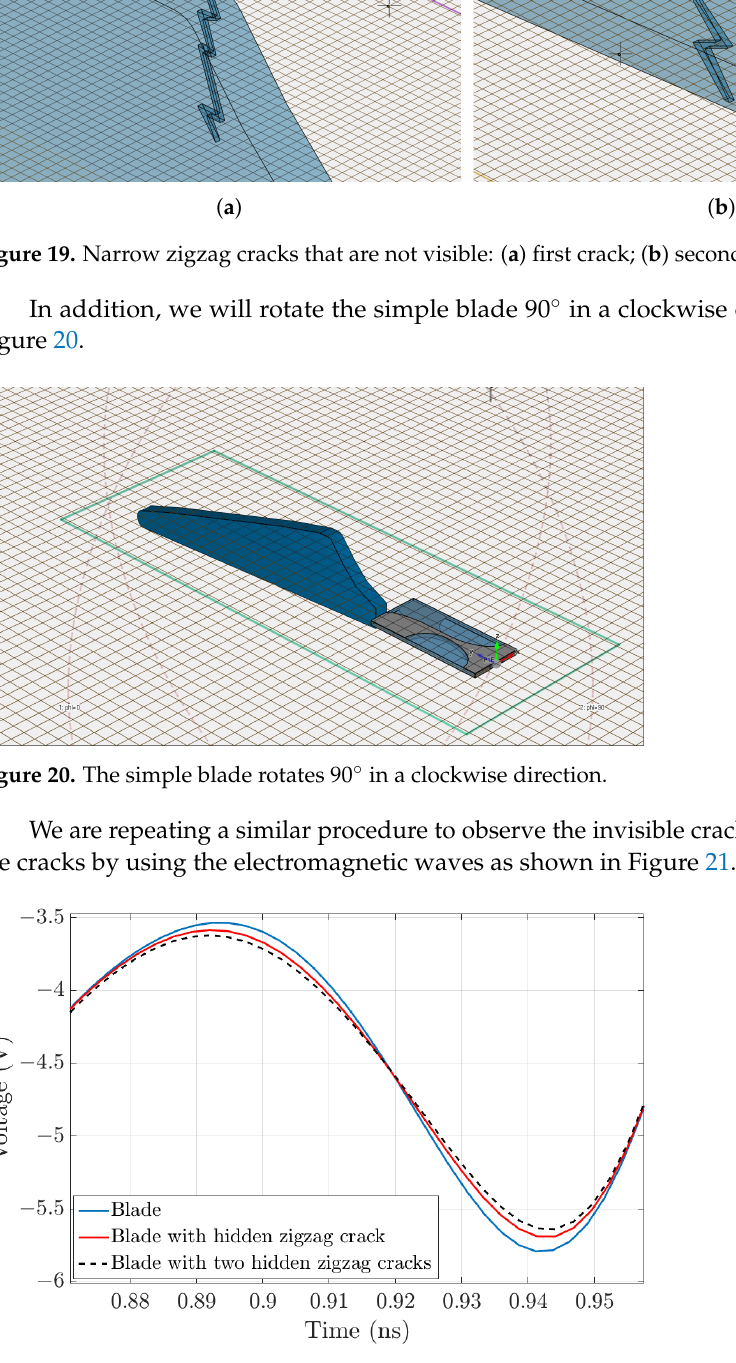
Figure 19, the length of the first and second zigzag cracks is 2.68 cm and 1.7 cm, respectively, and the minimum distance between the first and second cracks is 12.1 cm.